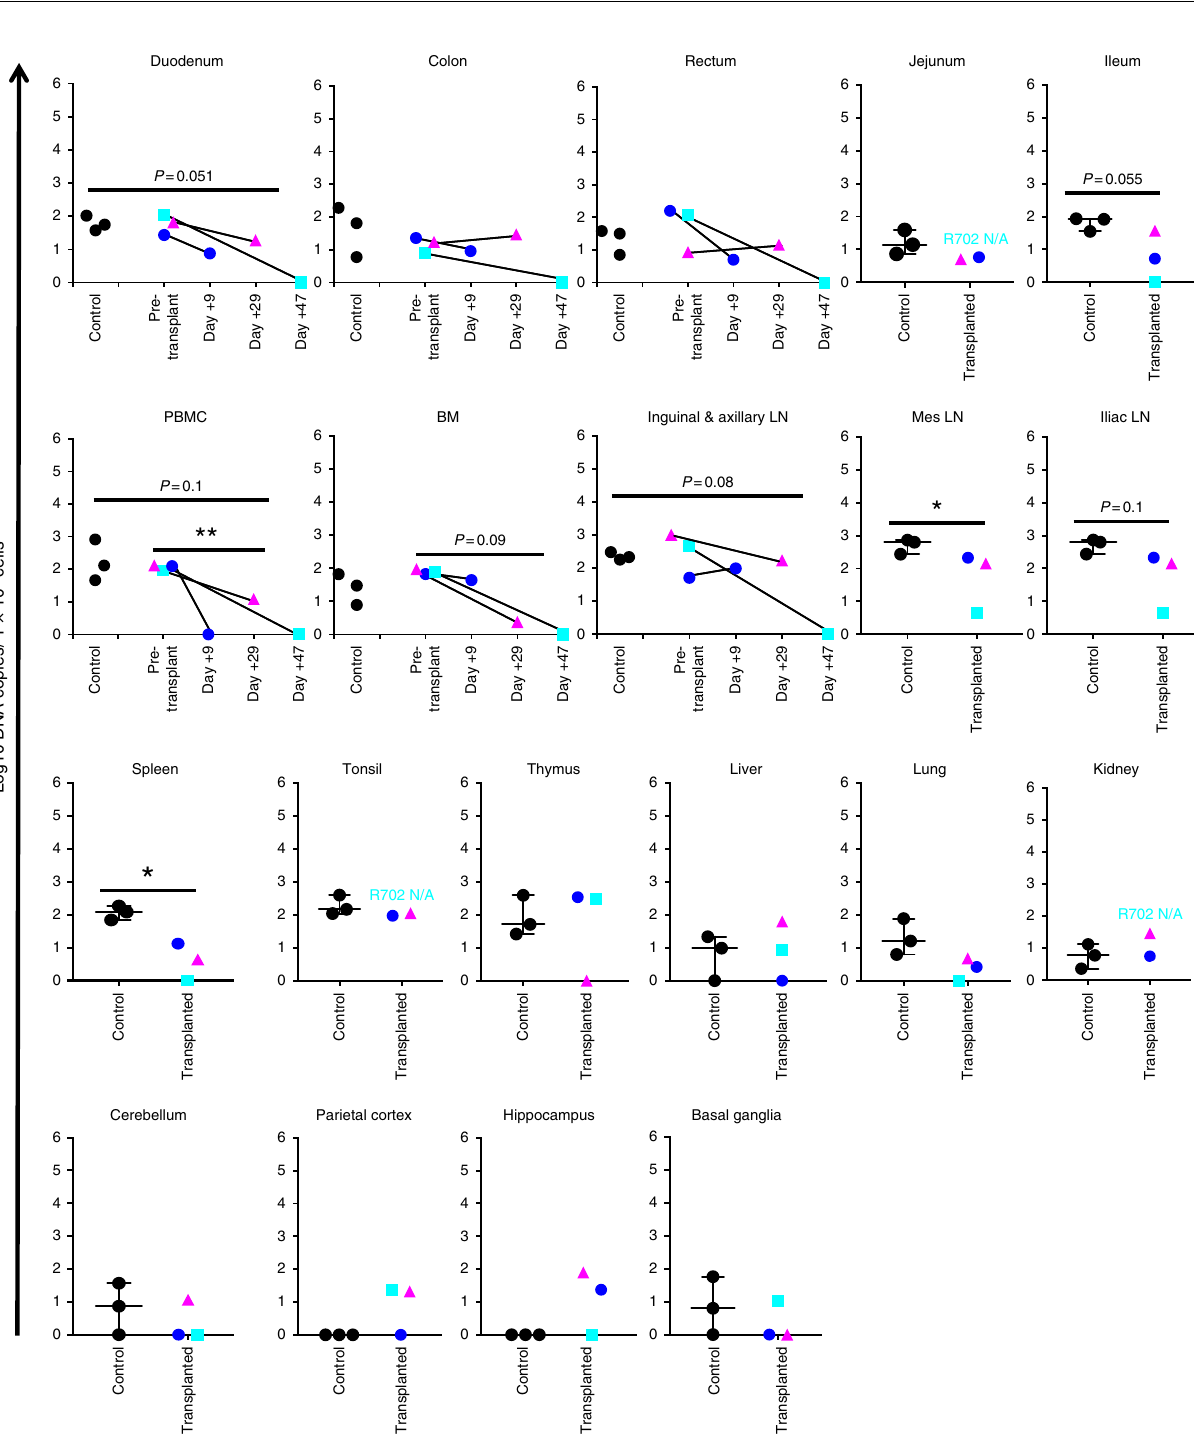
SHIV DNA measurements in donor vs. recipient subsets . A key unanswered question in suppressed HIV + patients undergoing allo-HCT is whether transplanted donor cells can be infected by